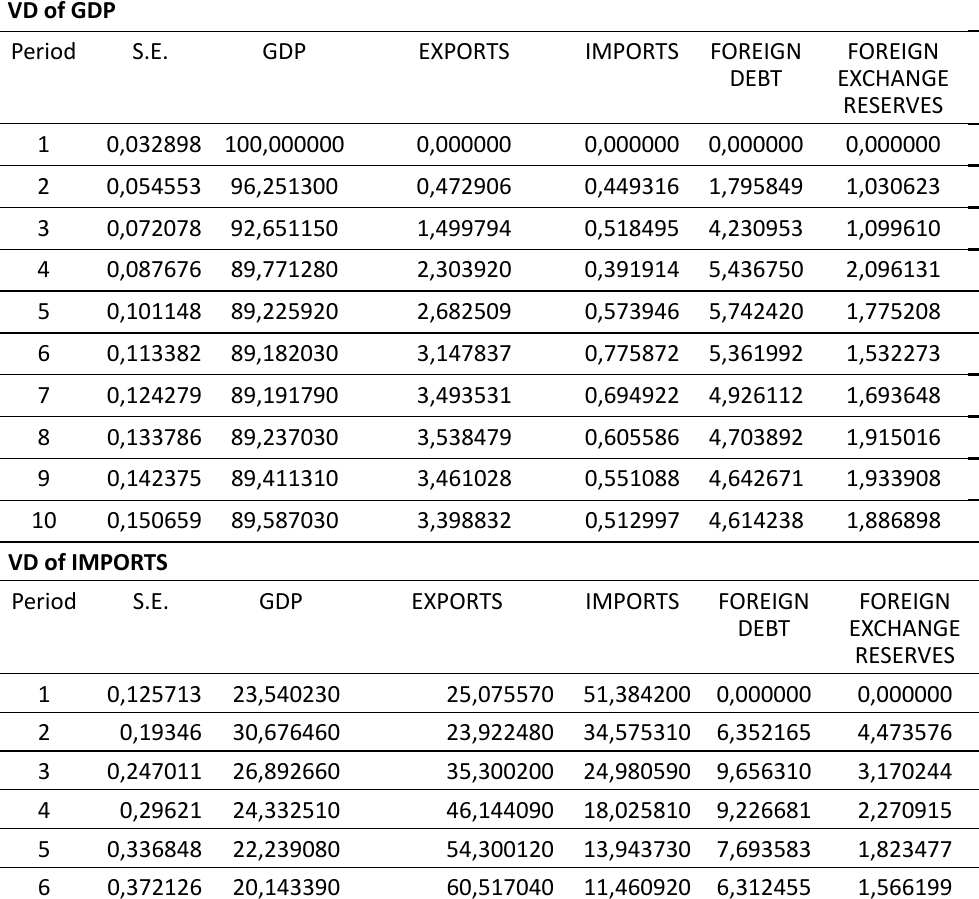
Table 6: VD Test of GDP and